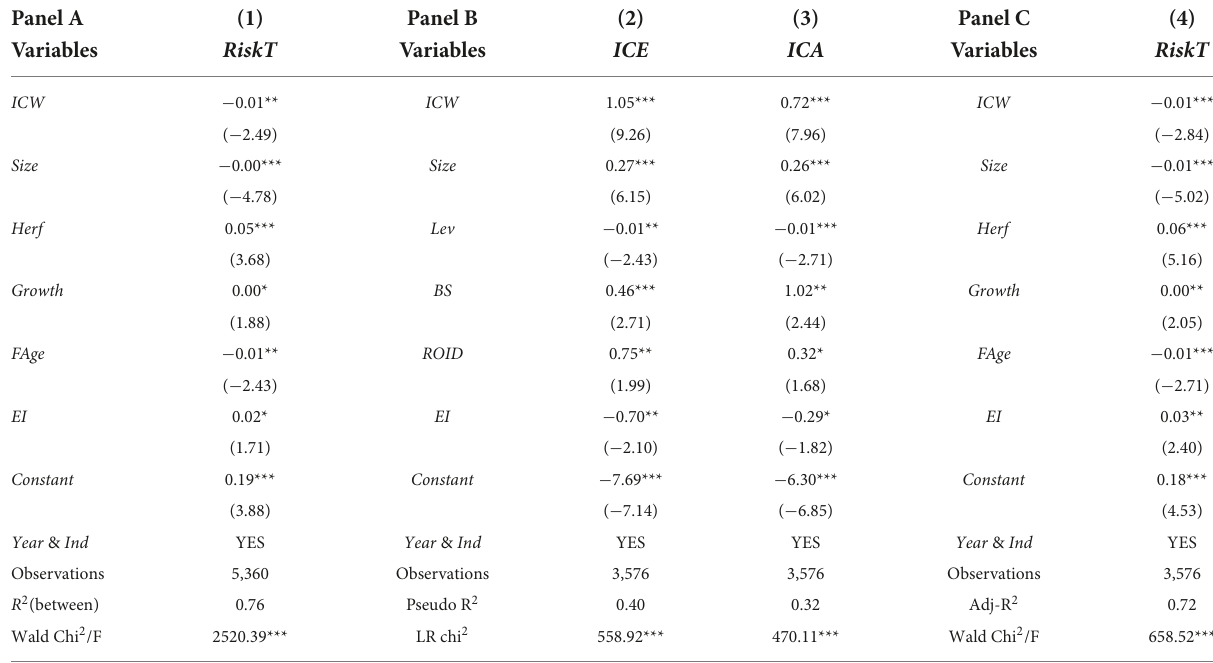
TABLE 4 Robustness test